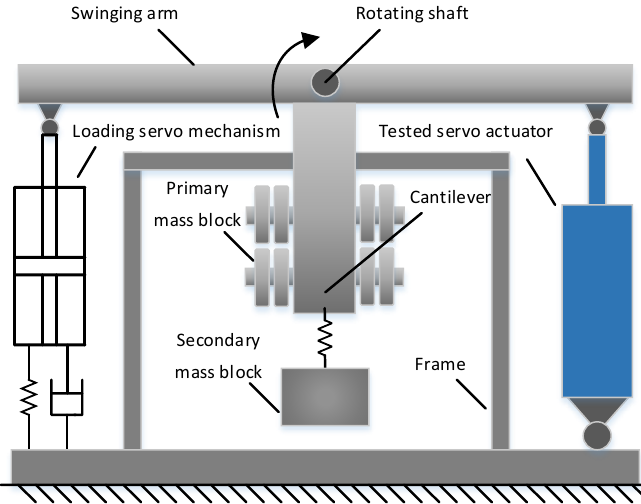
Figure 2. Structure sketch of the system.